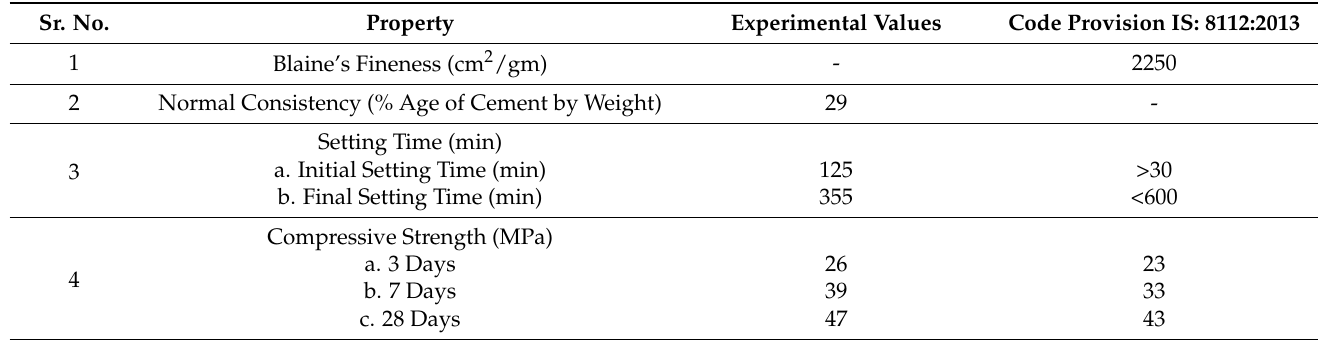
Table 1. Characteristics of ordinary Portland cement 43 Grade.